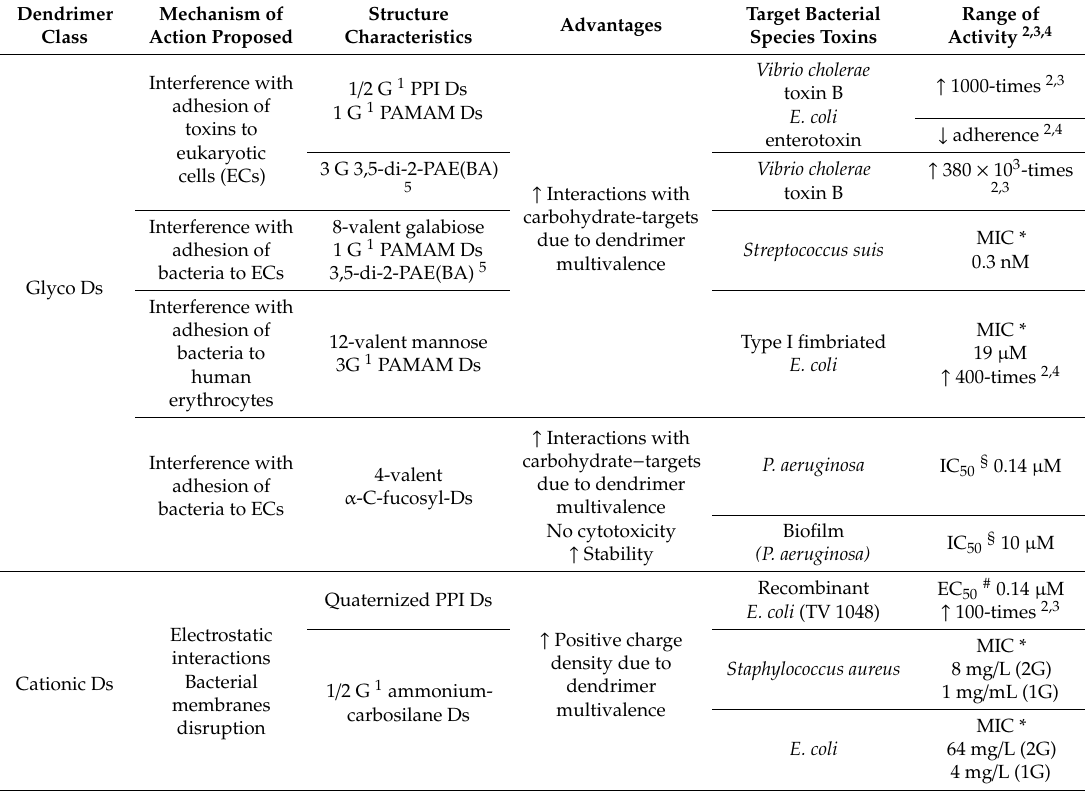
Table 3. Main types of antibacterial Ds developed in the years